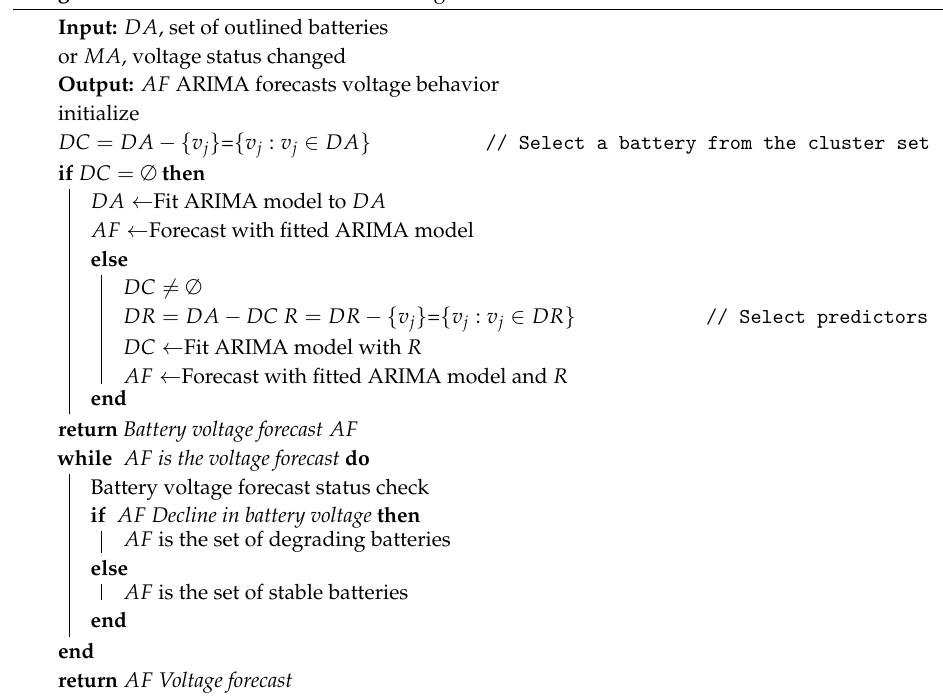
Algorithm 2: Clustered ARIMA